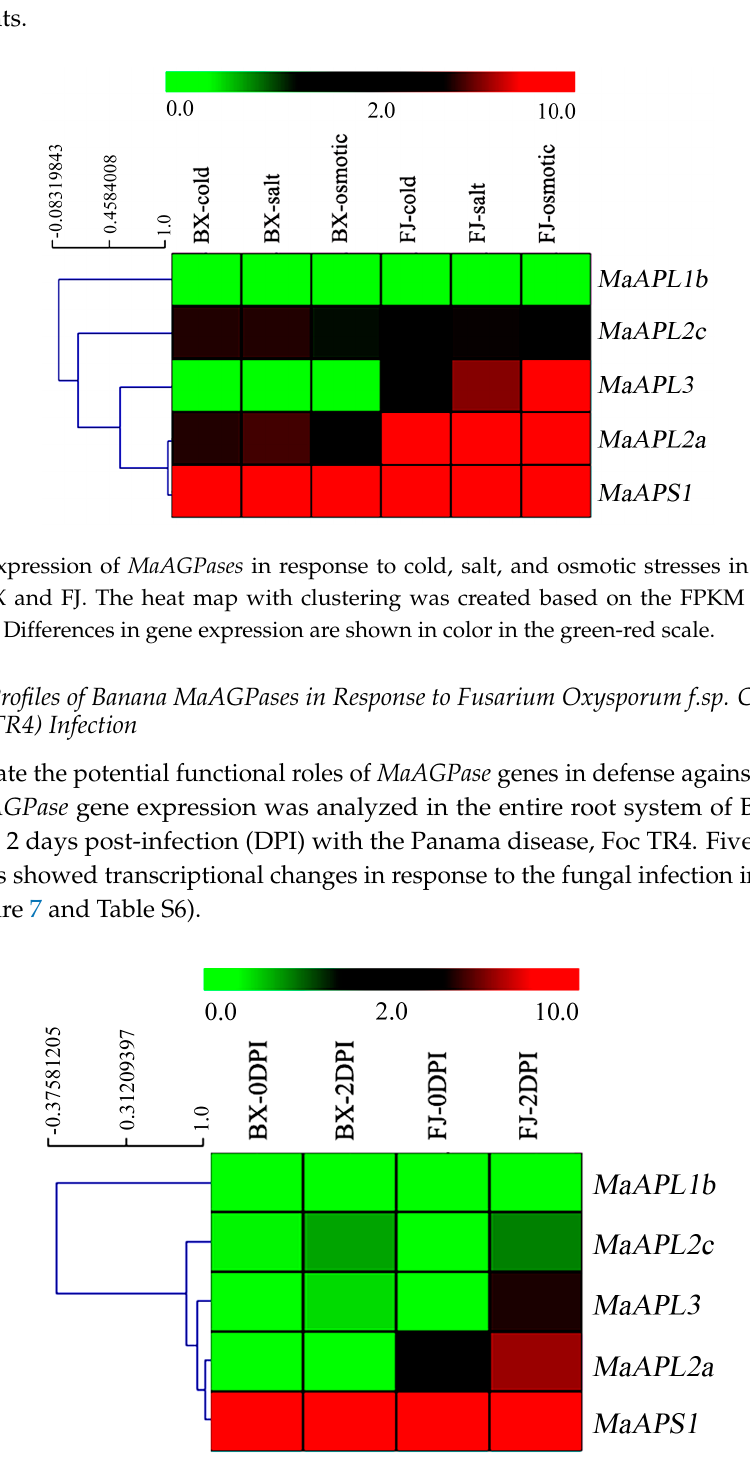
Figure 7. Expression of MaAGPases in response to fungal disease in two banana varieties, BX and FJ. The heat map with clustering was created based on the FPKM value of the MaAGPases . Differences in gene expression changes are shown in color in green-red scale.